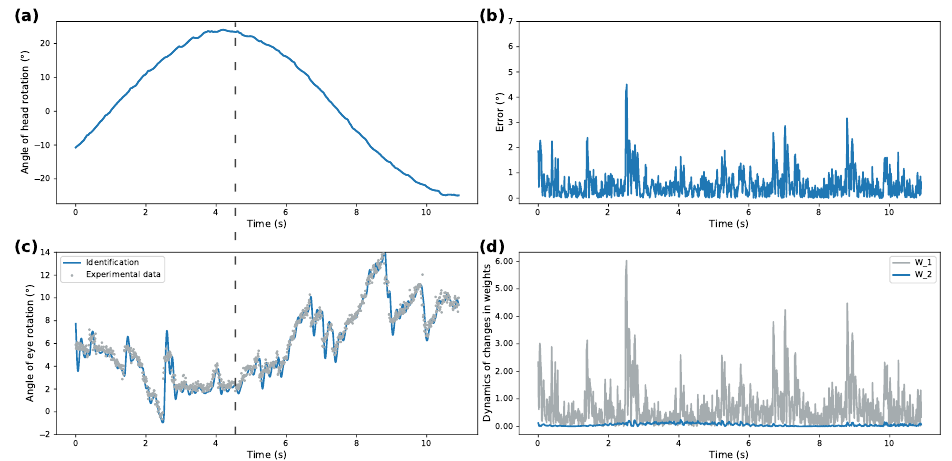
Figure 5. Identification with Izhikevich activation function for low-frequency rotations: ( a )—recorded head rotation; ( b )—identification error; ( c )—recorded data and identification results comparison; ( d )—evolution of weights.